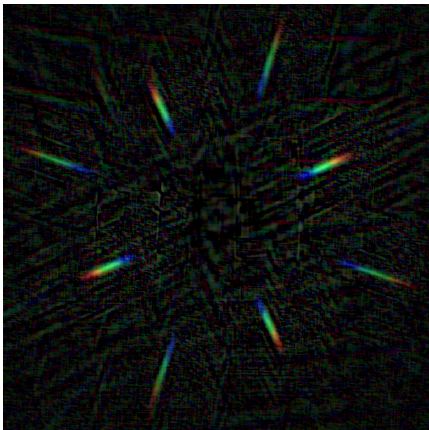
Figure 3. The 2D deconvolution result obtained from a diffraction image using a Dirac delta distri- bution as the regularization kernel k . In this case, the regularization term | ˆ k ( ξ ) | 2 in (4) is a constant (independent of ξ ). The computations were discretized using the discrete Fourier